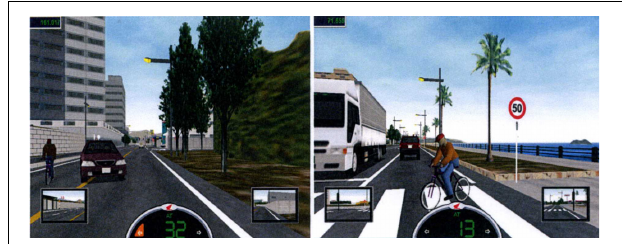
FIGURE 1 | Examples of risky scenes of the Honda Riding Trainer (HRT)